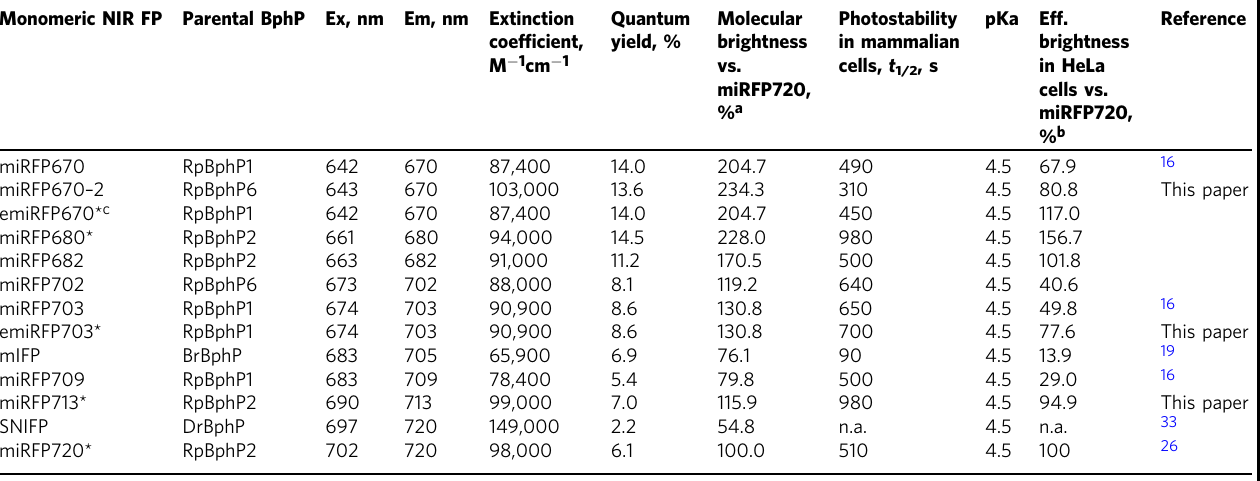
A set of fi ve spectrally distinct monomeric NIR FPs, which is recommended for further use in imaging applications, is marked with